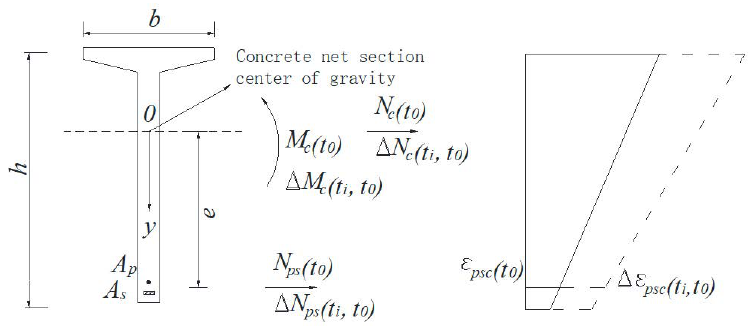
Figure 1. Calculation of prestress losses of prestressed concrete